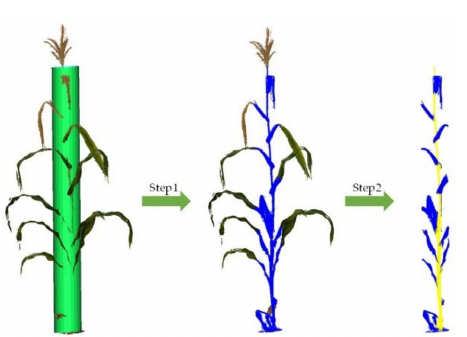
Figure 5. Schematic diagram of the stem division method. The spatial position of the green cylinder is determined by the red point cloud in Figure 4. RANSAC algorithm was used to extract stem point cloud from point cloud in